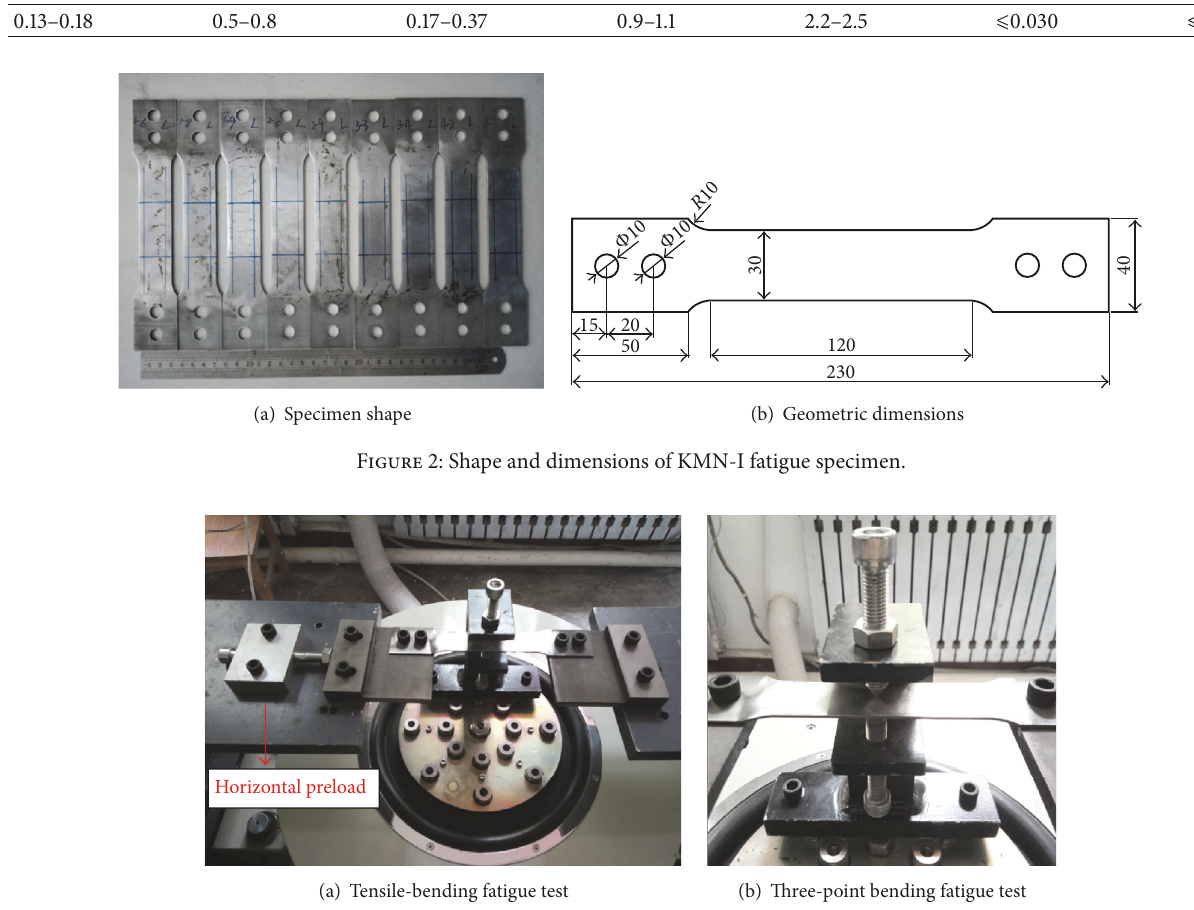
Figure 3: Vibration testing and fixture.